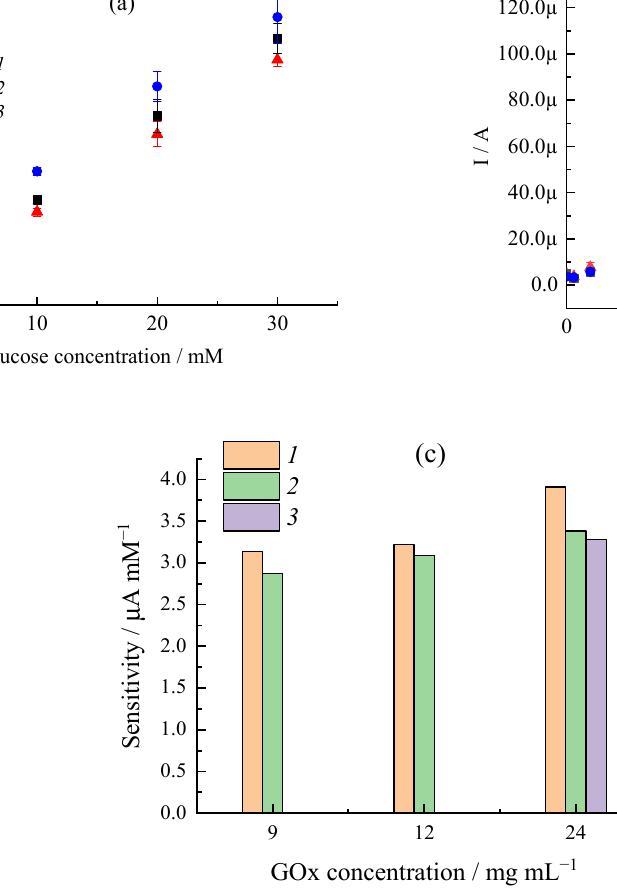
Figure 1. ( a , b ) Calibration curves obtained from SPE modified by 10CMC/25ALG/200FC ( a ) and 10CMC/50AS/200FC ( b ) gels with GOx concentration of 1–9 mg/mL, 2–12 mg/mL, 3–24 mg/mL. ( c ) Sensitivity of glucose test-strips based on ALG (1) and AS (2) gels in comparison with the conventional gel based on CMC (3) evaluated in LDR 0–40 mM. Note: Glucose solutions were prepared in the synthetic plasma at 36 °C and pH 7.4.